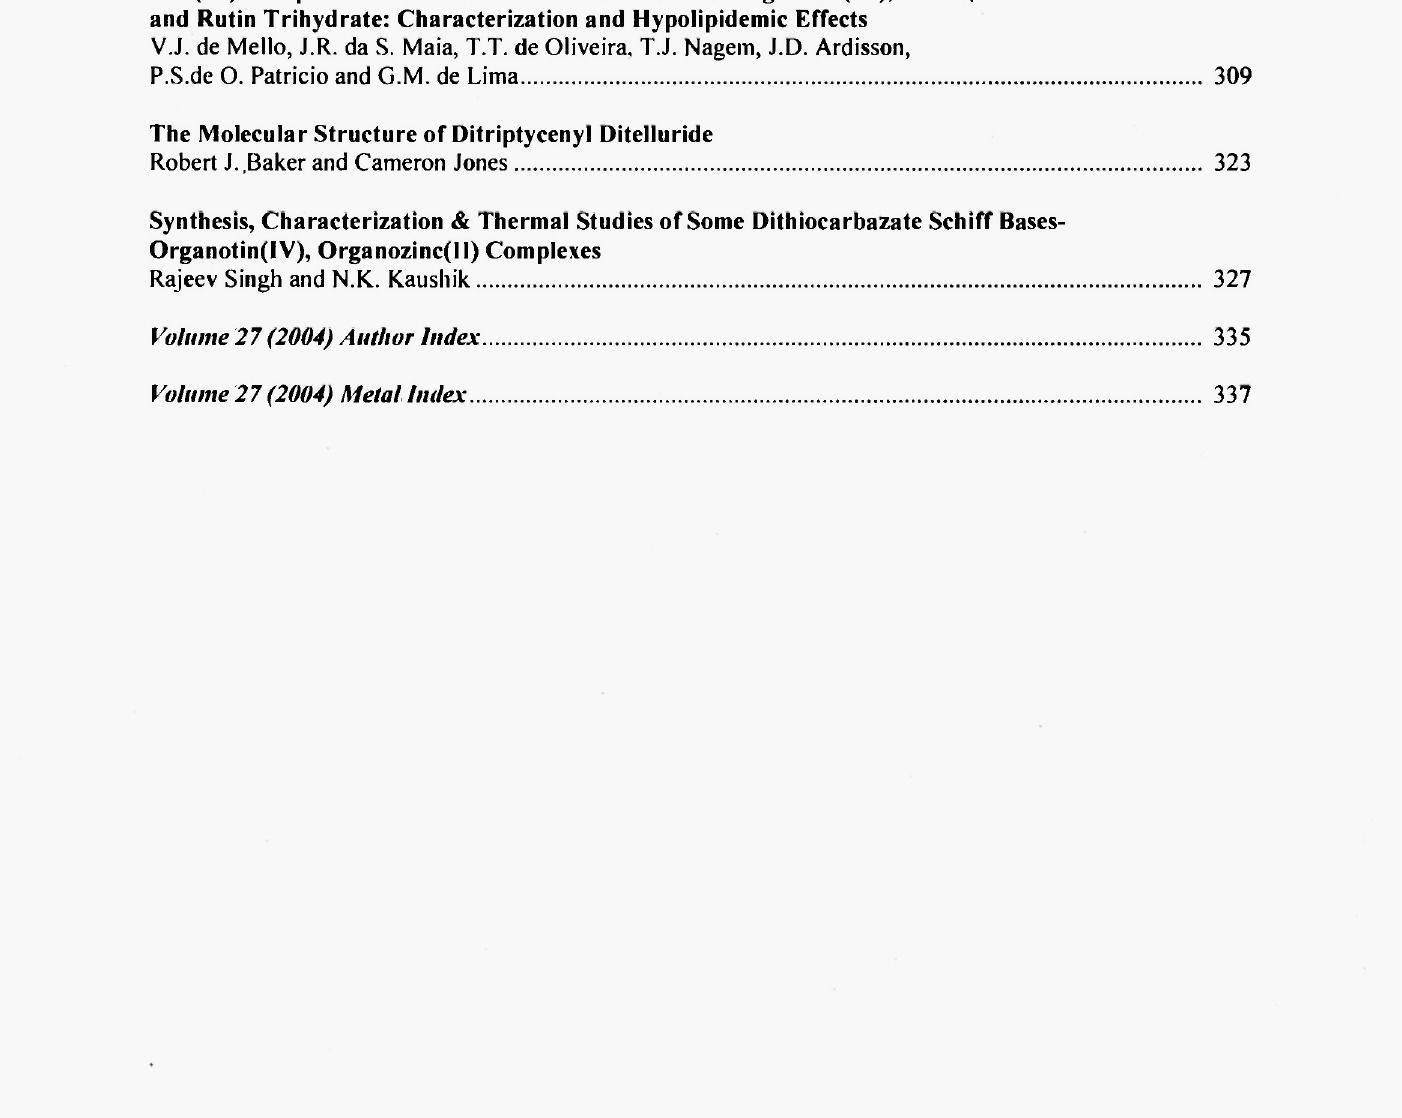
The Molecular Structure of Ditriptycenyl Ditelluride